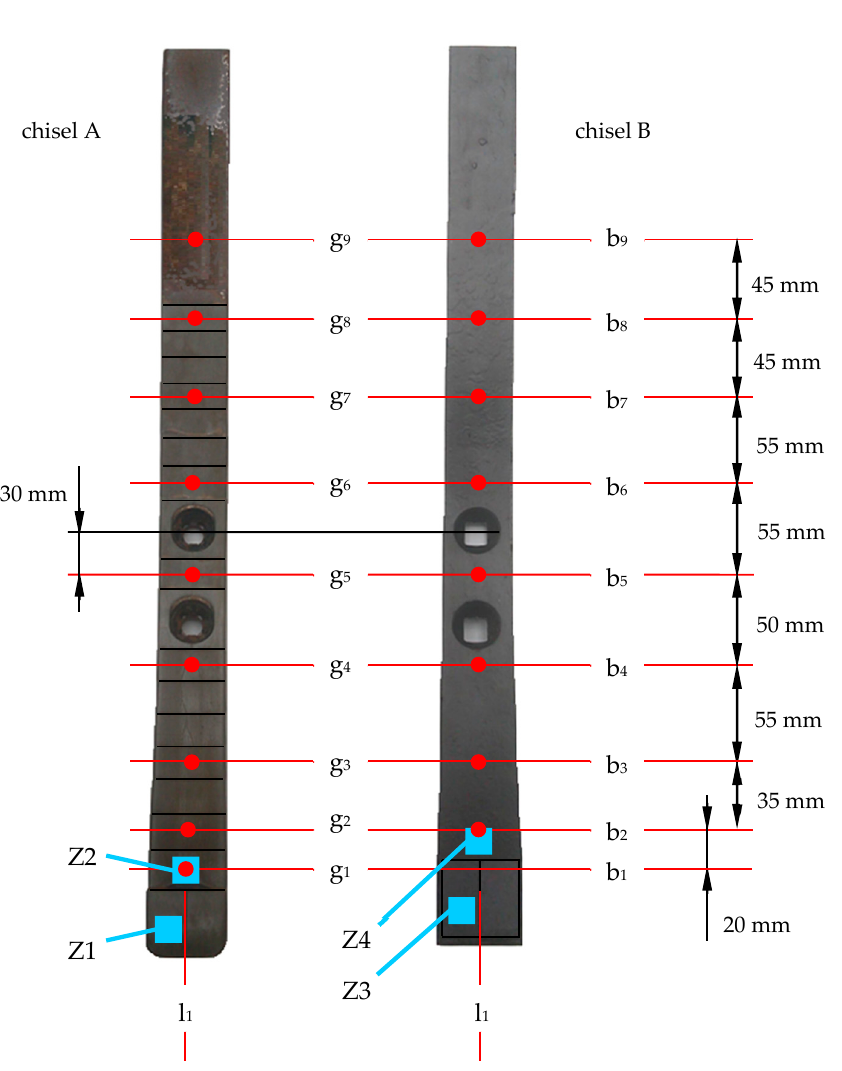
Figure 4. Thickness loss measurement points (for chisels A from g 1 to g 9 , for chisels B from g 2 to g 9 ), width loss measurement lines (from b 1 to b 9 ), length loss measurements line (line l 1 ), and scanning electron microscope (SEM) observation zones (from Z1 to Z4) of the rake surface topography of chisels after their operating in the soil.